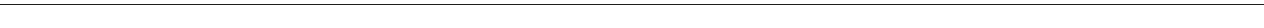
Fig. 3 Analysis of grasping trajectories indicating the ef fi ciency of each rehabilitative schedule to promote recovery of impaired grasping function after stroke. For all fi ve rehabilitative paradigms a – e grasping kinematics (left panel) at baseline (cyan-yellow trajectories) and 35d after stroke (blue-magenta trajectories) were compared. The grasping kinematics are represented by comparing the individual postures of a grasping sequence against a dictionary of prototypical postures and visualizing the resulting distance vectors using a two-dimensional distance preserving embedding. The two axes correspond to major variations in posture represented in units of baseline standard deviation (SD). Postures of an individual grasp are linked using a polygonal chain (100 grasping events for baseline and 100 grasping events for 35d after stroke per group) and color indicates the progress of a grasp over time from beginning to end. The superimposed lines represent the average reprogression of the individual grasps for baseline and 35d post insult. Midpoint is when the paw is closest to the pellet. Moreover, we sampled postures from different areas of this embedding to show differences/similarities between 35d after stroke and baseline for the different cohorts. The right bar panel summarizes how much behavior at baseline and at 35d after stroke differs at different stages of grasping. Grasps are split into fi ve disjoint time intervals and we compute the distance between baseline and 35d relative to the SD of the baseline. On top right of each group a – e selected frames of the grasping trajectory are depicted at the same time points (1. – 4./5.) for baseline (BL) and 35 days post stroke highlighting the divergence/convergence at the end point of the rehabilitative treatment compared to baseline. Animals in the “ Delayed Training ” group b failed to regain the supination motion for the fi nal targeting of the pellet 35d after stroke compared to baseline ( > 1 SD for the fi rst two disjoint time intervals, right panel bars), while animals in the “ Spontaneous recovery ” group a still showed too short grasps ( > 1 SD for the fi rst time interval, right panel bars) even 35d after stroke (as indicated in the red boxes for 2. and 3. for the two